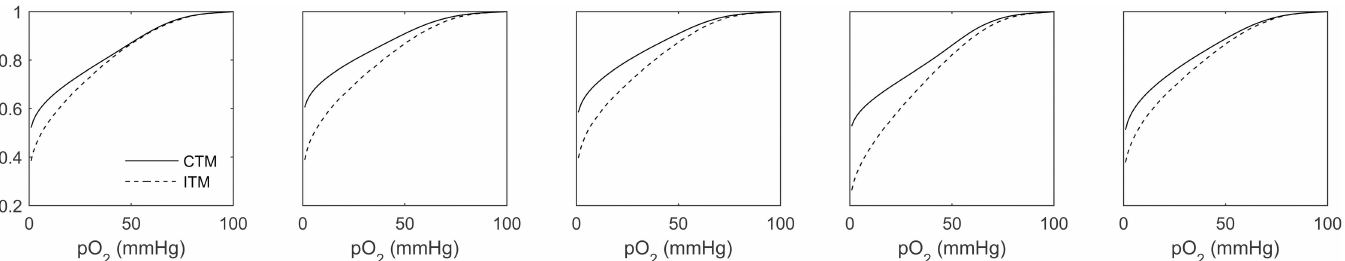
Fig 7. Oxygen distributions. CumulativepO 2 distributionsfor the five sample volumes. The resolutionis 1